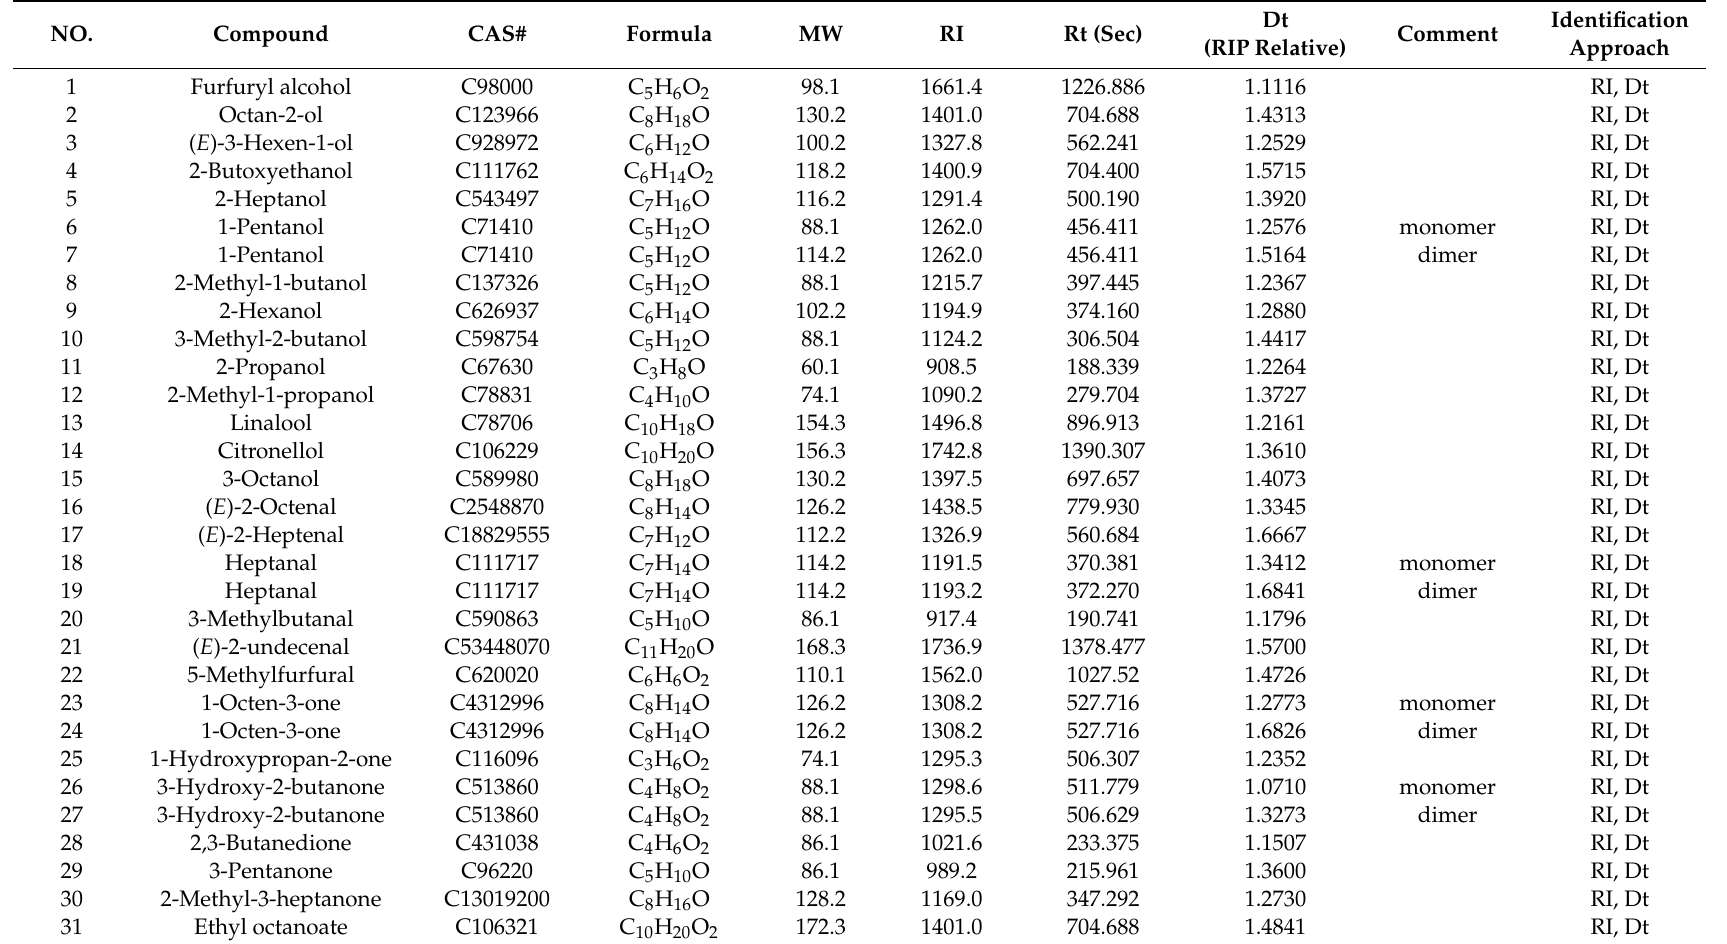
Table 1. The information on identified compounds of jujube